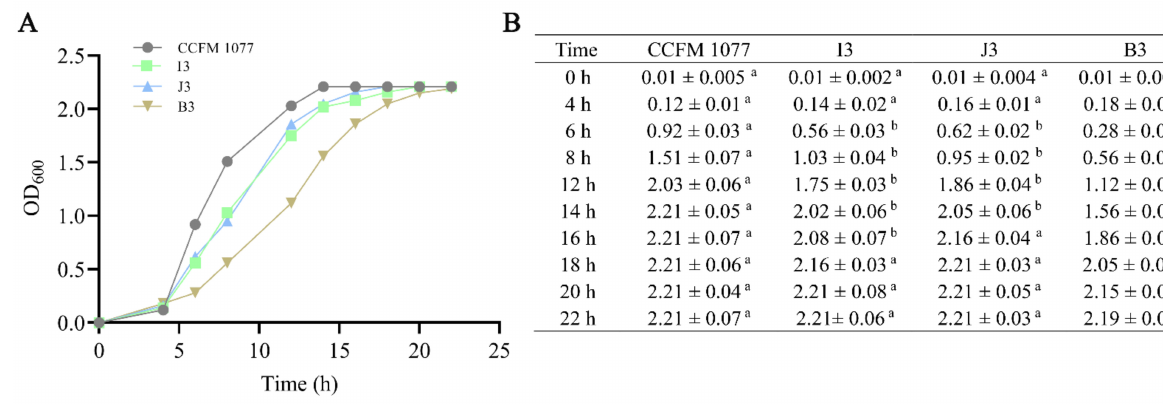
Figure 1. Growth status of four B. longum strains. ( A ) Growth curves of four B. longum strains. The X-axis is the culture time of four B. longum strains, and the Y-axis is the absorbance of culture liquid at 600 nm. The OD 600 was tested three times at different time points (0, 4, 6, 8, 12, 14, 16, 18, 20 and 22 h). The data are expressed with the average of three OD 600 values at each time point. ( B ) All OD 600 values are means ± standard error of the mean. a, b, c: Means in the same row with different superscript letters are significantly different ( p < 0.01) based on determination using a one-way ANOVA followed by Tukey multiple comparison test.